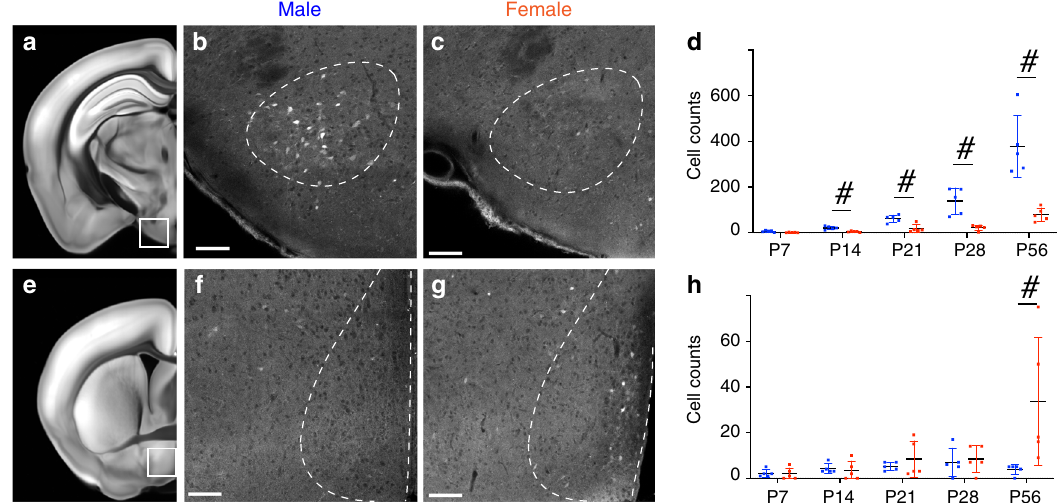
Fig. 7 Sexually dimorphic expression of OTR neurons. a – d The PMv showed signi fi cantly higher density of OTR cells in males than females from P14. e – h In contrast, the AVPV near the medial preoptic nucleus showed signi fi cantly higher OTR cells in females than males at P56, but not before. The fi rst column is to highlight anatomical regions of interest in an adult reference brain. The second and the third columns are zoomed-in pictures from P56 adult male and female OTR-Venus brains, respectively. Scale bar in b , c , f , g = 100 µ m. The last column is number of OTR-Venus ( + ) cells in the anatomical regions over time (error bars = mean ± standard deviation). Blue dots for males and red dots for females. # Denotes statistically signi fi cant difference between males and females with false discovery rate <0.05 after multiple comparison correction.